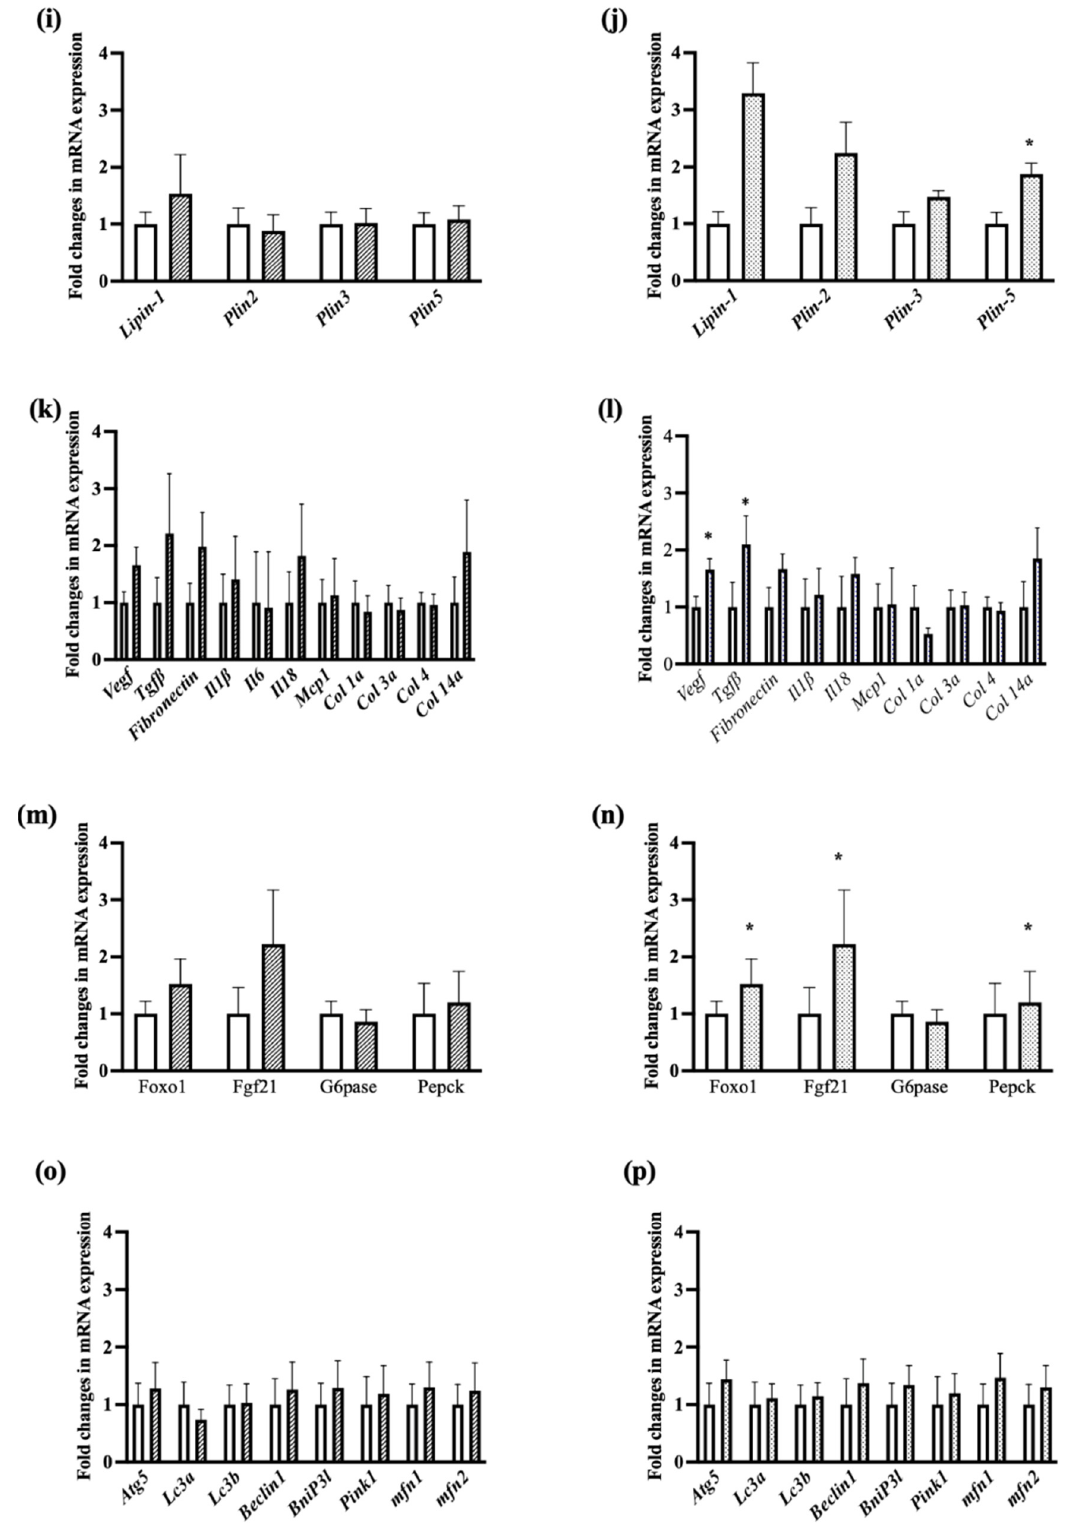
Figure 5. Fold changes in mRNA expression in liver tissue. The left panel is for control vs E4 mice and the right panel is for control vs chow mice. Genes involved in fatty acid uptake ( a , b ), de novo lipogenesis ( c , d ), Fat oxidation ( e , f ), TG synthesis ( g , h ), intracellular lipid transport, lipid loading and droplet formation ( i , j ), fibrosis and inflammation ( k , l ), glucose and insulin metabolism ( m , n ), mitochondrial dysfunction, autophagy and apoptosis ( o , p ). n = 5 Welch’s t -test: * p < 0.05.